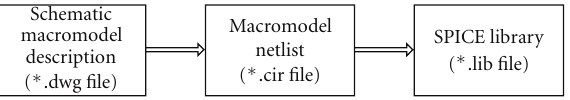
Figure 2: Block diagram of the Spice macromodel